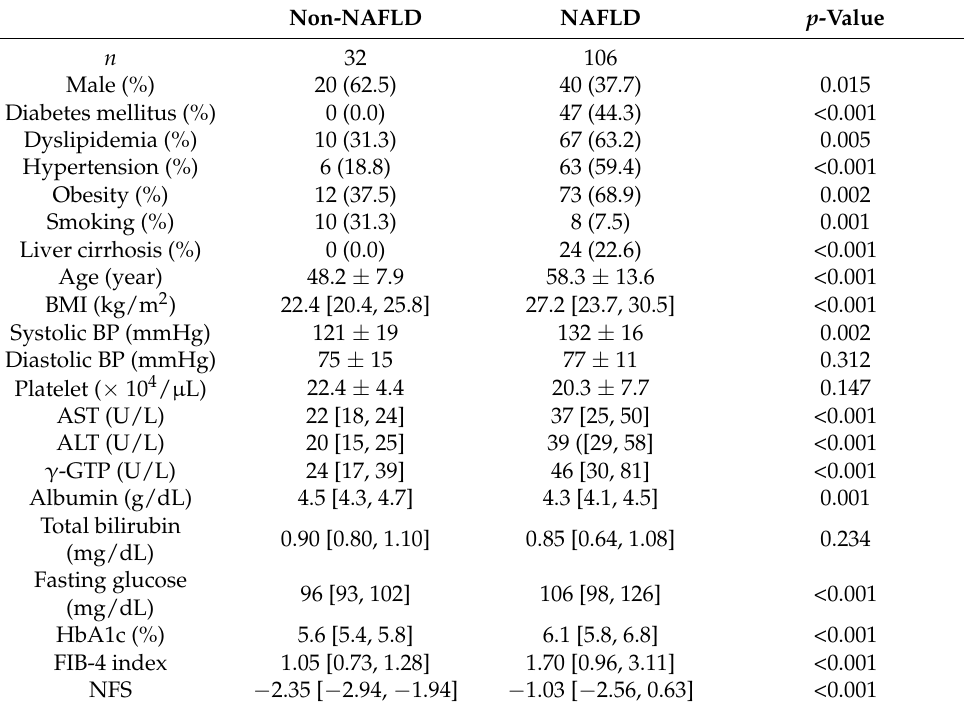
Table 2. Characteristics of subjects enrolled in the present